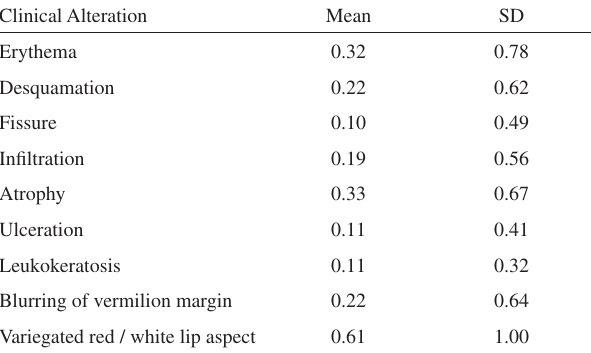
Table 1 - Lower lip clinical alterations in the fishermen